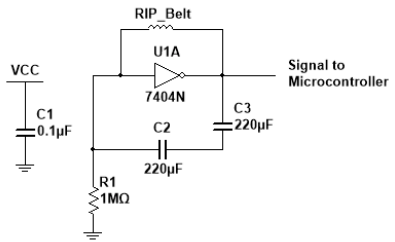
Figure 6. LC oscillator circuit employed for RIP sensing.